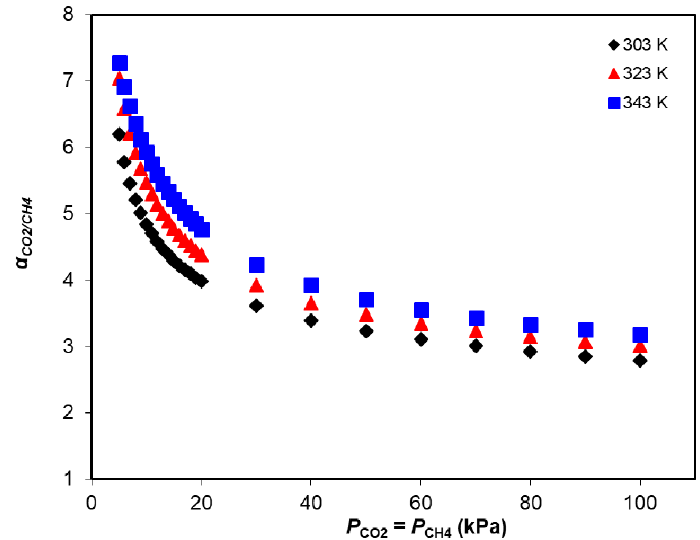
Figure 10. CO 2 / CH 4 ideal selectivity as a function of the partial pressure in an equimolar mixture at 303 K ( ♦ ), 323 K ( ▲ ), and 343 K ( ■ ).